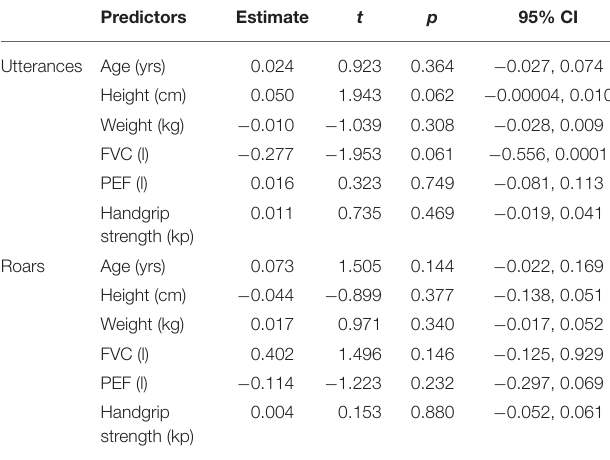
TABLE 3 | Summary of linear mixed effects model analysis for physical fitness predictors of perceived fighting ability based on utterances and